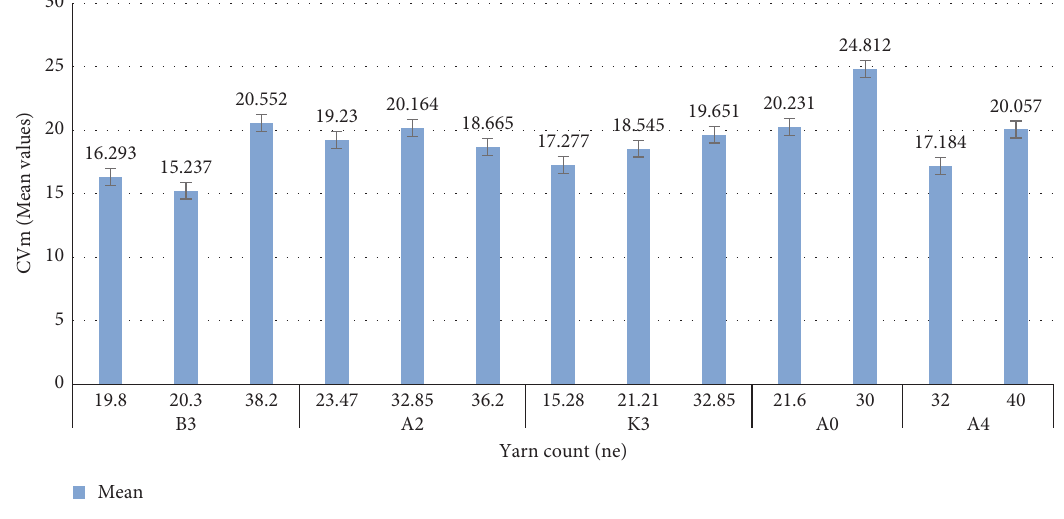
Figure 1: Yarn evennenes analysis.